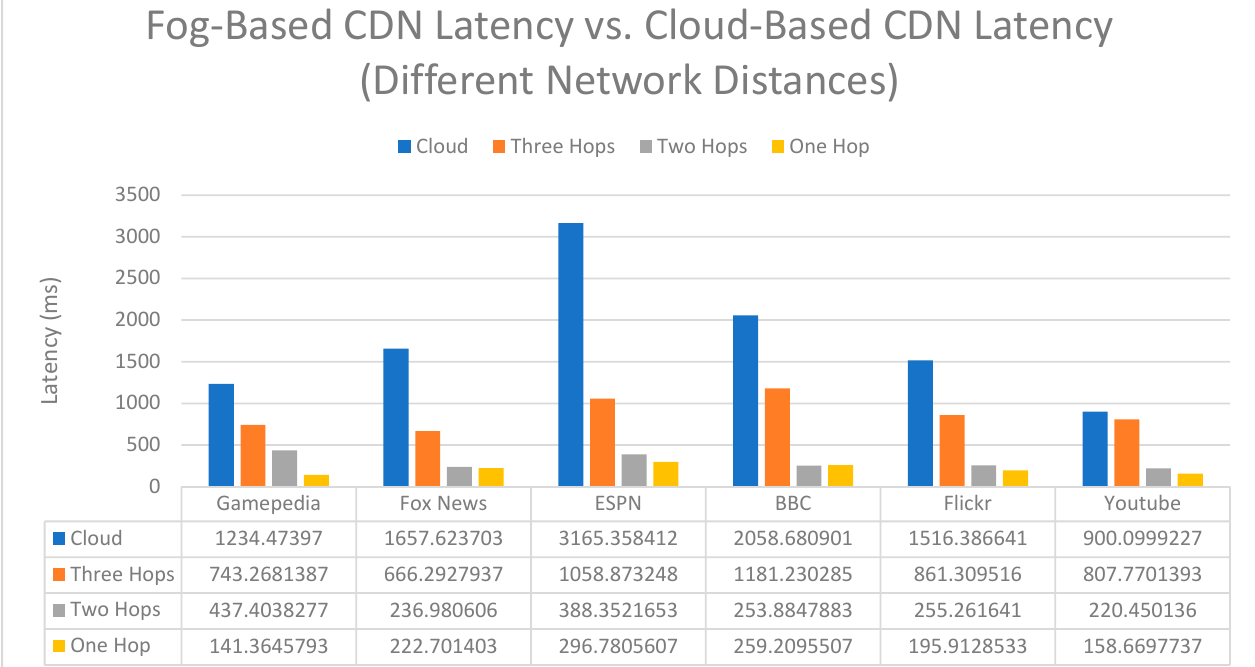
Figure 9. Fog-based CDN latency (different network distances) vs. cloud-based CDN latency.